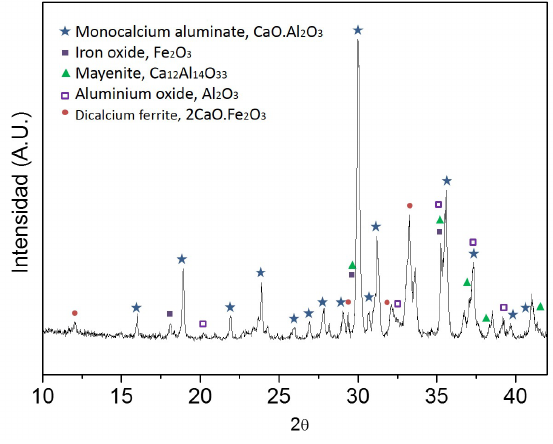
Figure 4. XRD Spectrum of Aluminate Ternal RG.